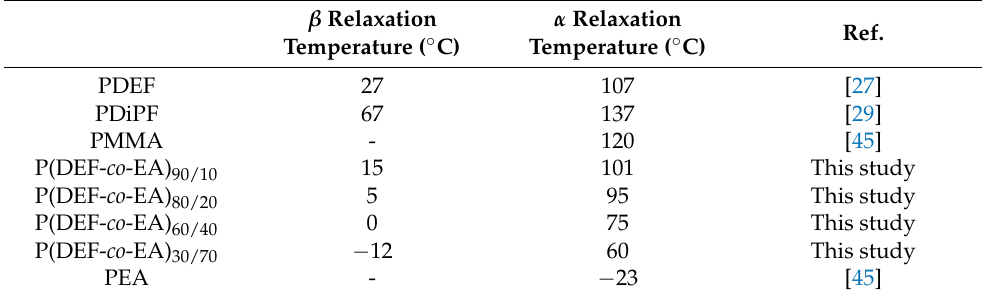
Figure 2. DSC profiles of P(DEF- co -EA) 90/10 and P(DEF- co -EA) 30/70 . There are two thermal anomalies even in the copolymer containing the 30 % DEF segment. The scale bar corresponds to 0.05 W/g. The other DSC data of copolymers with different fumarate segments are provided in the supporting information. The sample was quenched from 150 ◦ C. Table 2. β and α relaxation temperatures of PDEF, PDiPF, PMMA, PEA, and P(DEF- co -EA) with different fractions of fumarate segment. These values are determined by DSC with a scanning speed of 3 ◦